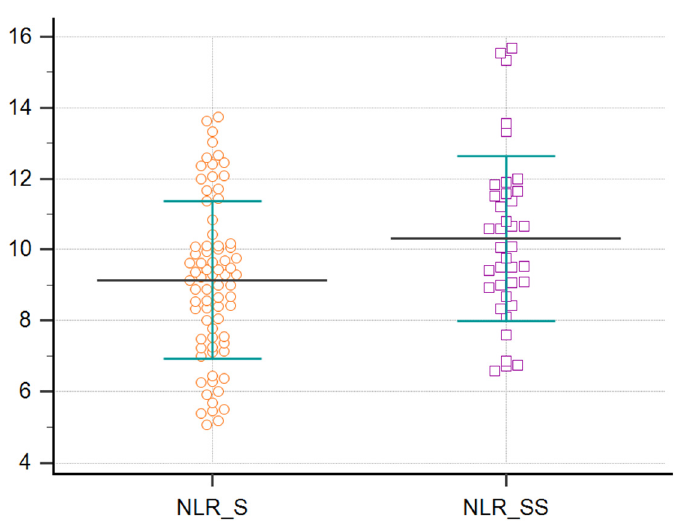
Figure 1. NLR values for patients with sepsis (NLR_S) and septic shock (NLR_SS). Data represented as mean, standard deviation (SD), and individual patient value markers.